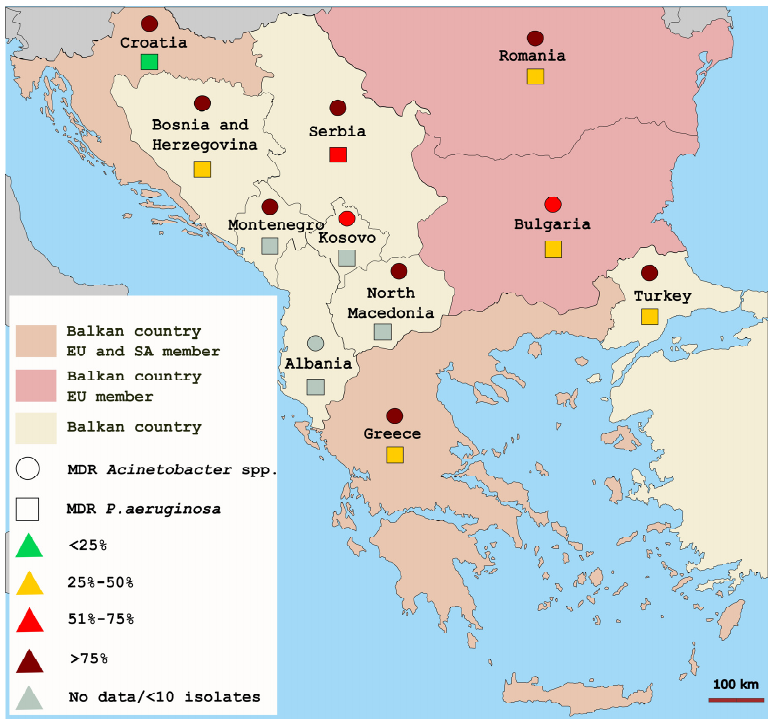
Figure 2. Geographic distribution of invasive multidrug-resistant Acinetobacter spp. and P. aeruginosa on the Balkans according to the 2020 annual report of the ECDC [37]. MDR, multidrug-resistant; EU, European Union; SA, Schengen Area.